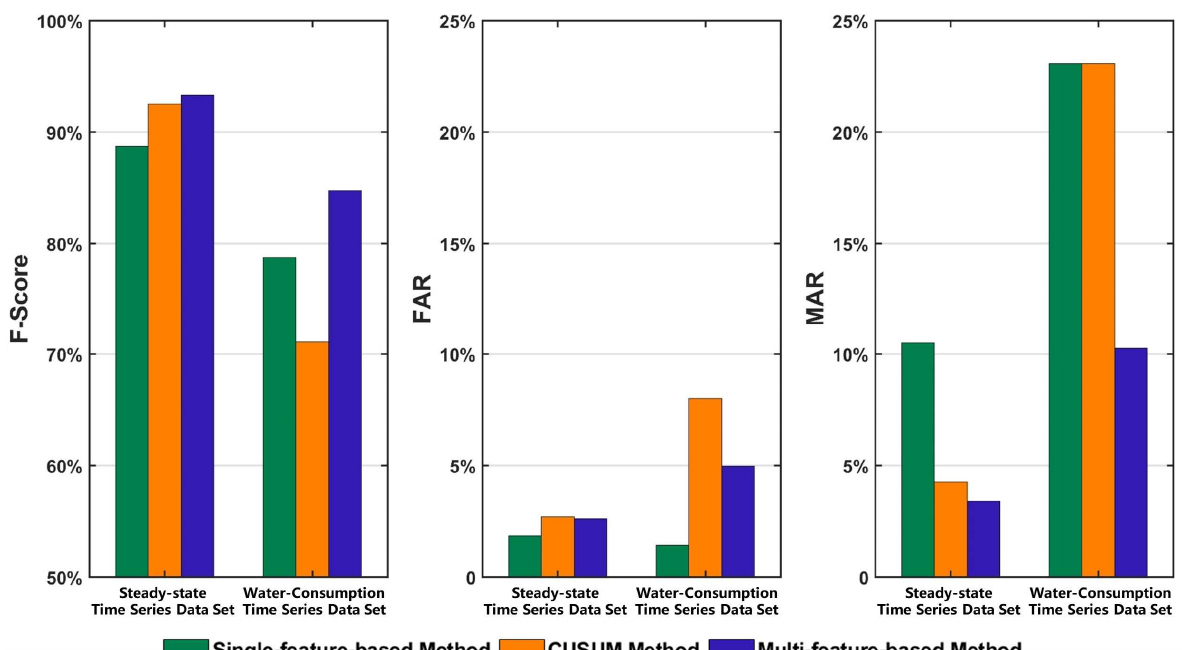
Figure 12. Comparison of F-Scores, FARs, and MARs of the different methods.